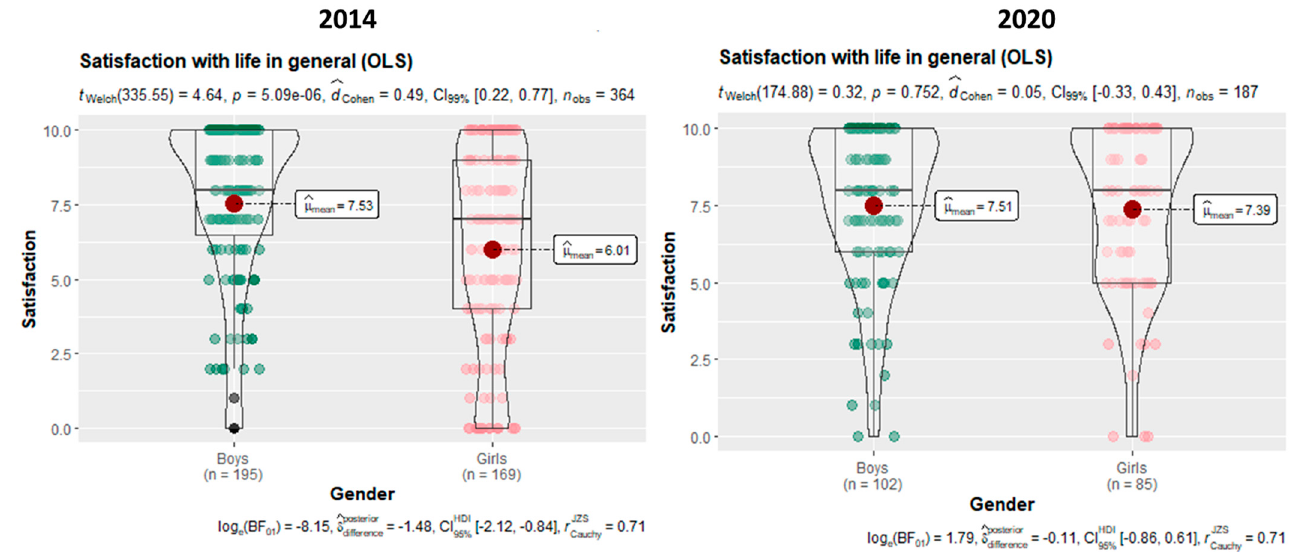
Figure 2. Comparison of means for Overall Life Satisfaction (OLS) by gender and year of data collection.